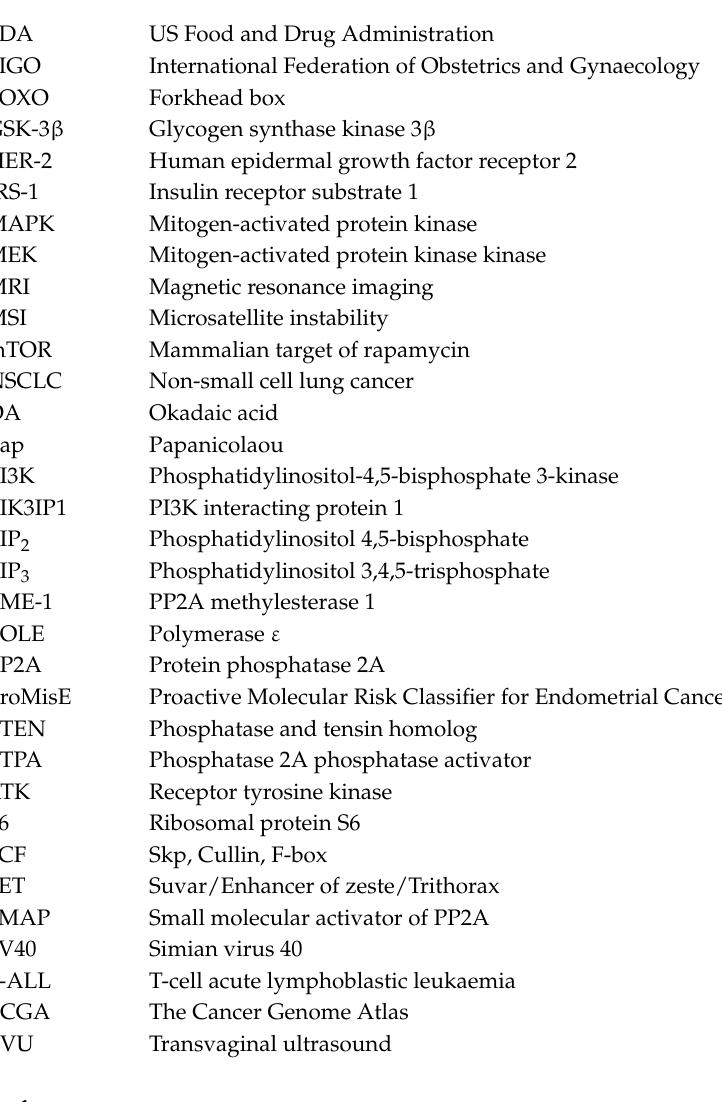
FDA US Food and Drug Administration FIGO International Federation of Obstetrics and